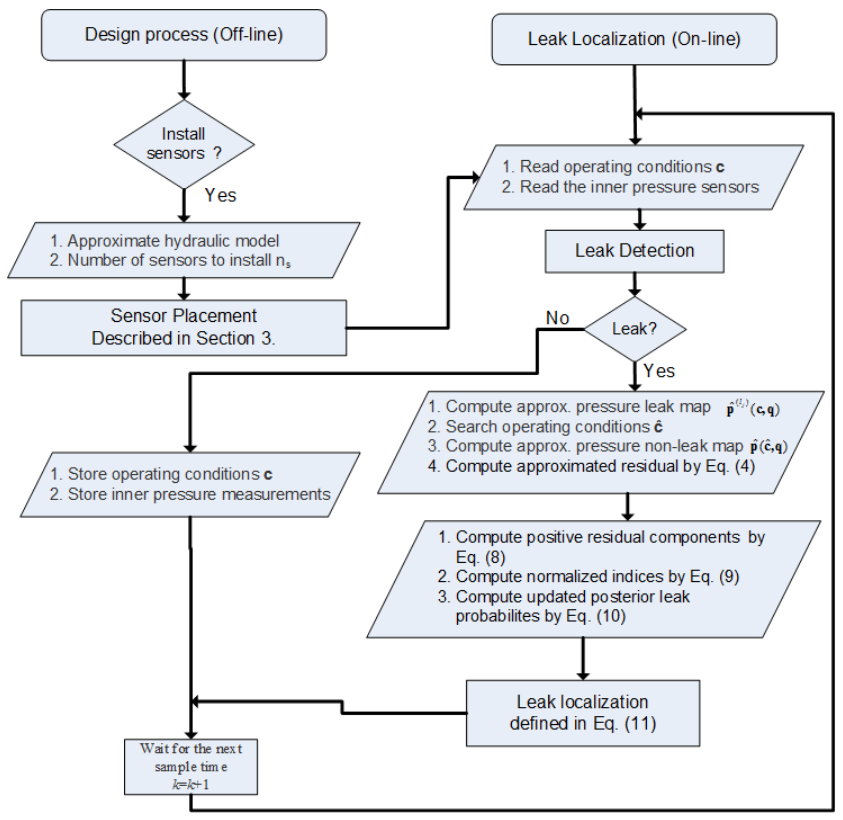
Figure 1. Proposed Method